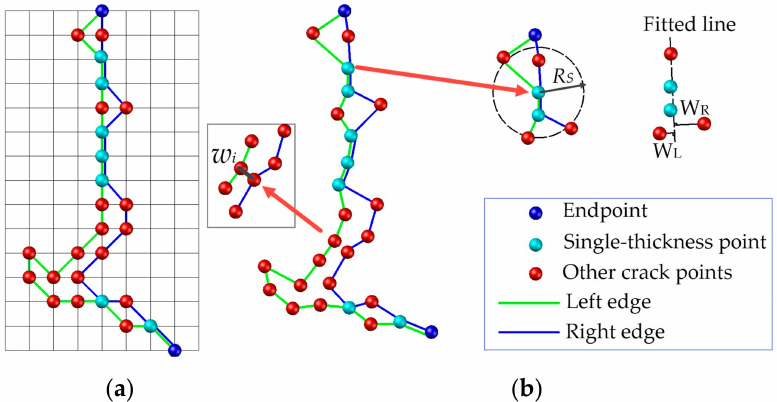
Figure 11. Edge points classification to calculate crack width, ( a ) in Tgrid, and ( b ) in geometrical